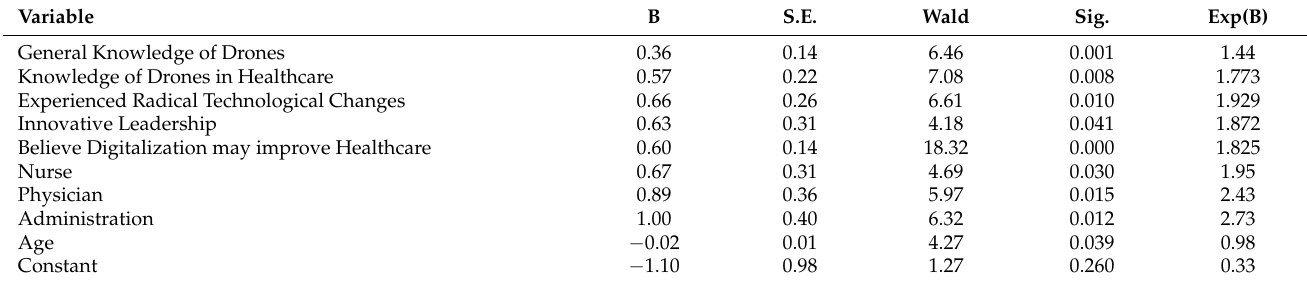
Table 3. Multivariate logistic regression with a belief in drone usage in future healthcare as the dichotomous dependent variable. Variable B S.E. Wald Sig. Exp(B) General Knowledge of Drones